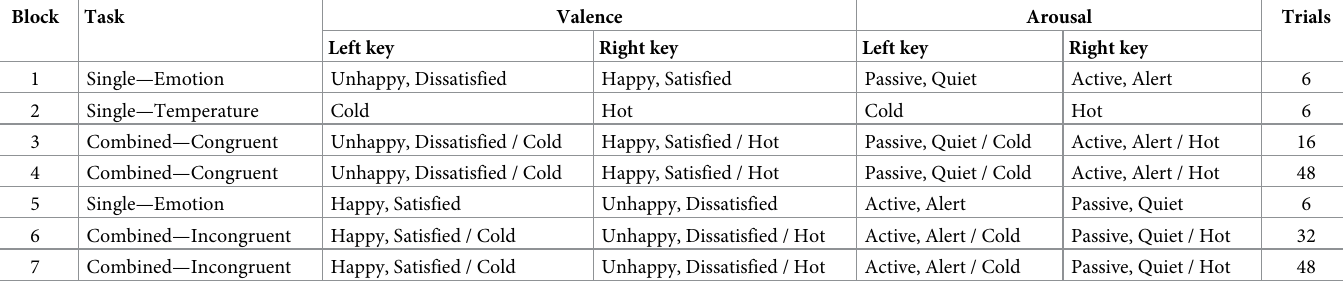
Table 3. Blocks and response mappings in Experiment